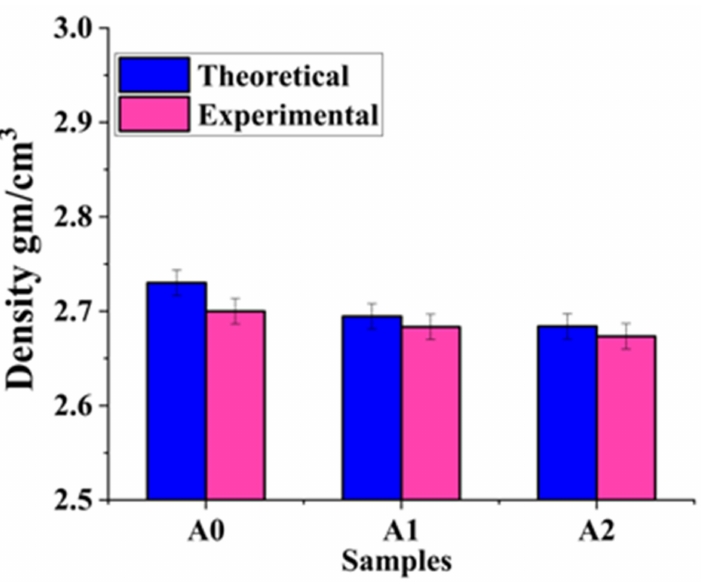
Figure 3. Theoretical and experimental